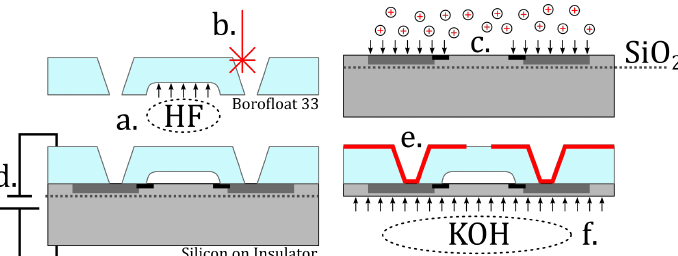
Figure 4. Schematic illustrating the production steps: ( a ) pressure reference cavity by HF wet etching into a 200µm Borofloat glass wafer; ( b ) TGV holes by femtosecond laser ablation; ( c ) the two-step local boron doping of piezoresistors and butterfly wiring; ( d ) anodic bonding of silicon and glass wafers; ( e ) metallization and realization of a CSP by gold magnetron sputtering and copper electroplating; and ( f ) membrane thinning by KOH wet etching, where the SOI silicon oxide layer serves as reliable etch stop